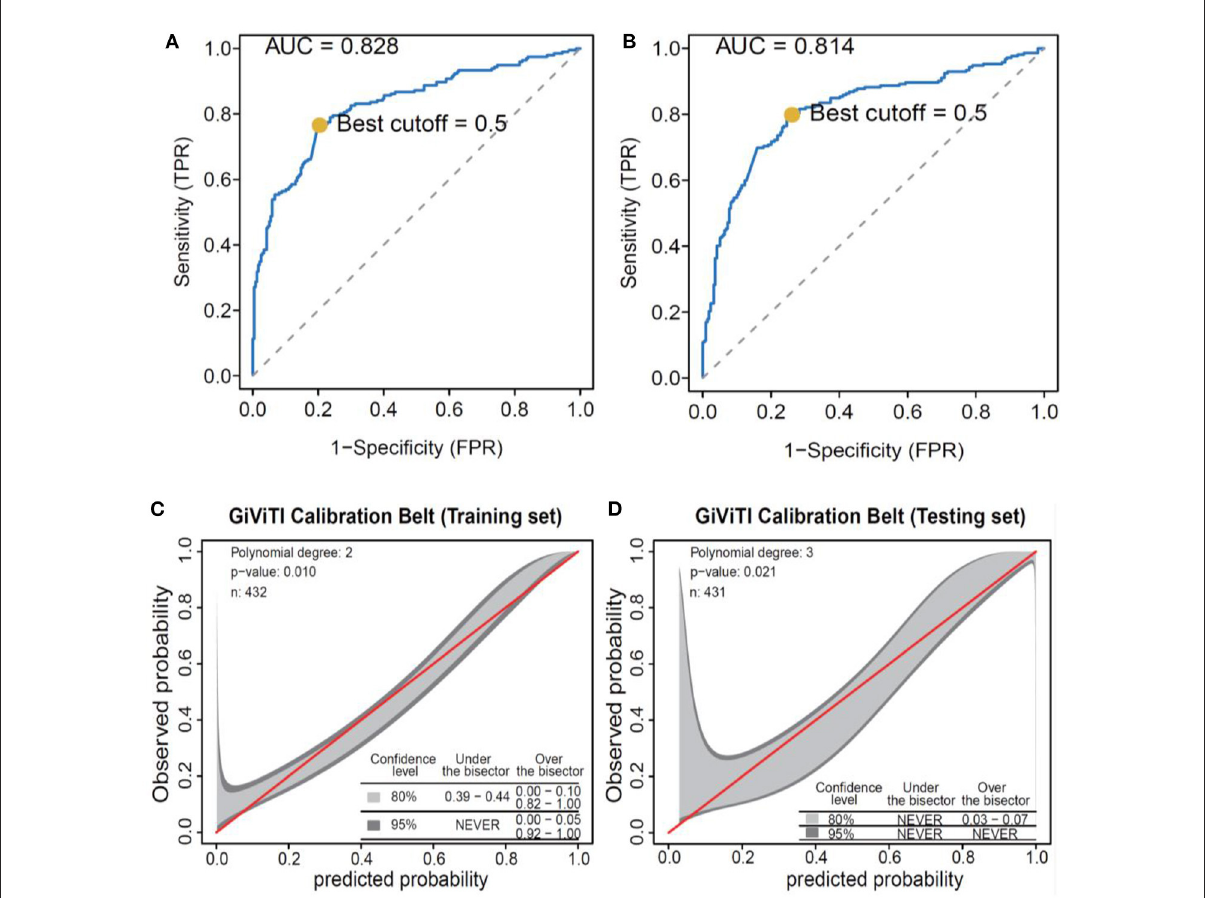
FIGURE3 Performance of the logistic regression algorithm in infectious disease prediction. (A) ROC curves of the training set. (B) ROC curves of the testing set. (C) GiViTI calibration curves of the training set. (D) GiViTI calibration curves of the testing set. ROC, receiver operating